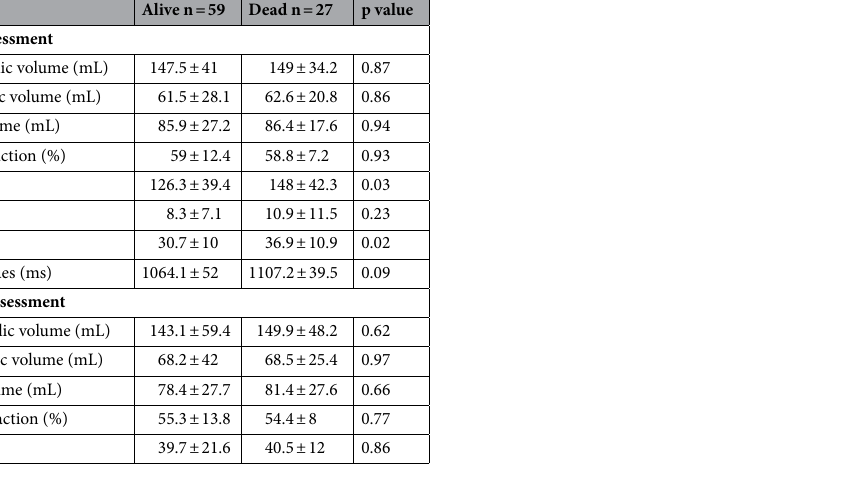
Table 2. Left and right heart functional CMR